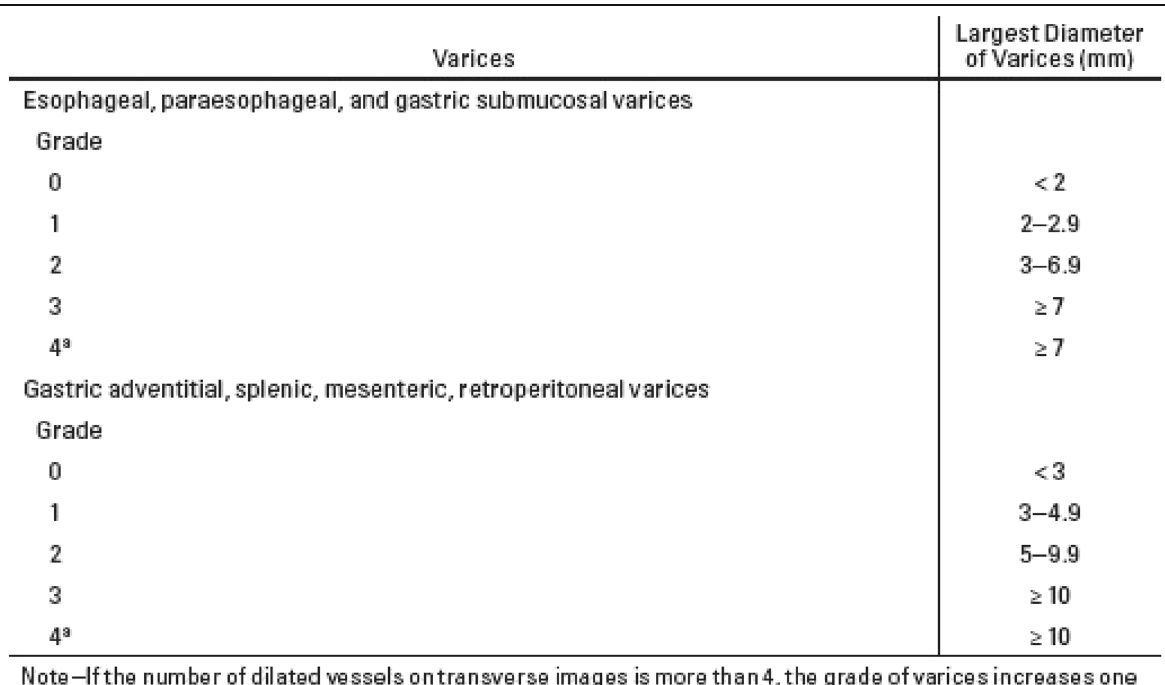
Table 1 Esophageal varices are graded by CT according to the following (Kim et al. 2008)